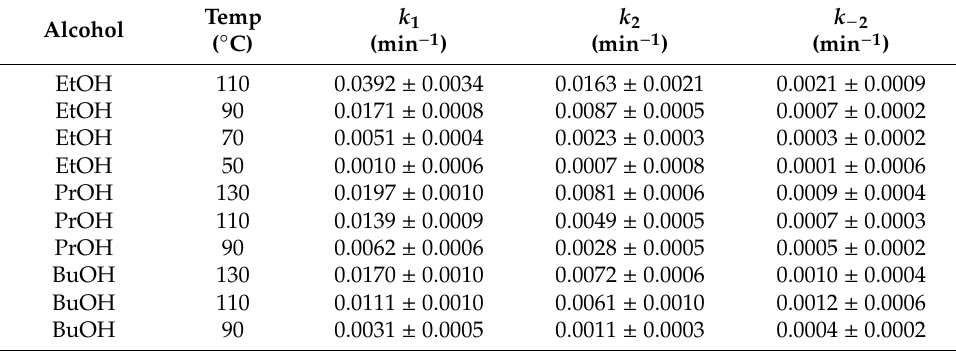
Table 2. Rate coe ffi cients for each experiment catalysed by Zn( 1 ) 2